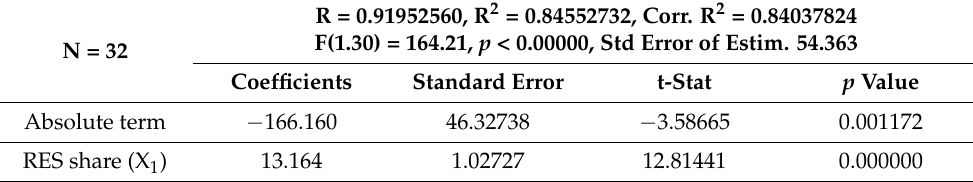
Table 7. The results of modeling the Gross Domestic Product in Sweden in 1991–2022 using a linear econometric model of one variable.